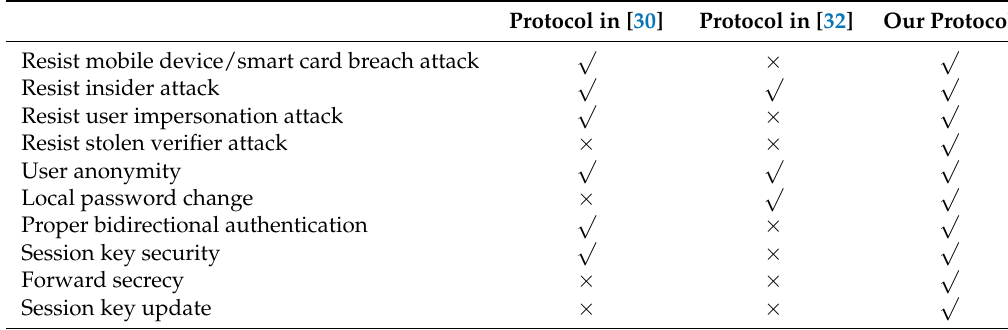
Table 2. Comparison of security and function